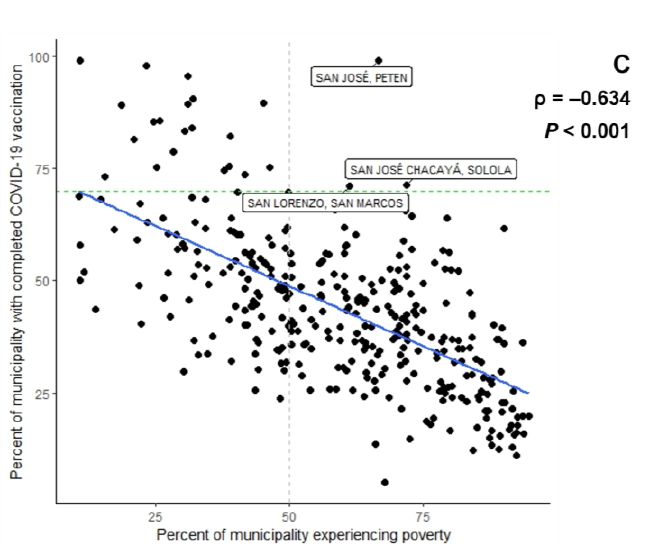
Figure 1. Guatemalan municipalities by percent of primary COVID-19 vaccination series coverage versus ( A ) percent of municipality population of Mayan identity, ( B ) percent of municipality population living in a rural area, and ( C ) percent of municipality population experiencing poverty. Labeled municipalities are those with >70% completed COVID-19 vaccination (green dashed line) and >50% of the Mayan population ( A ), rural residence ( B ), or people experiencing poverty ( C ) (gray dashed line).